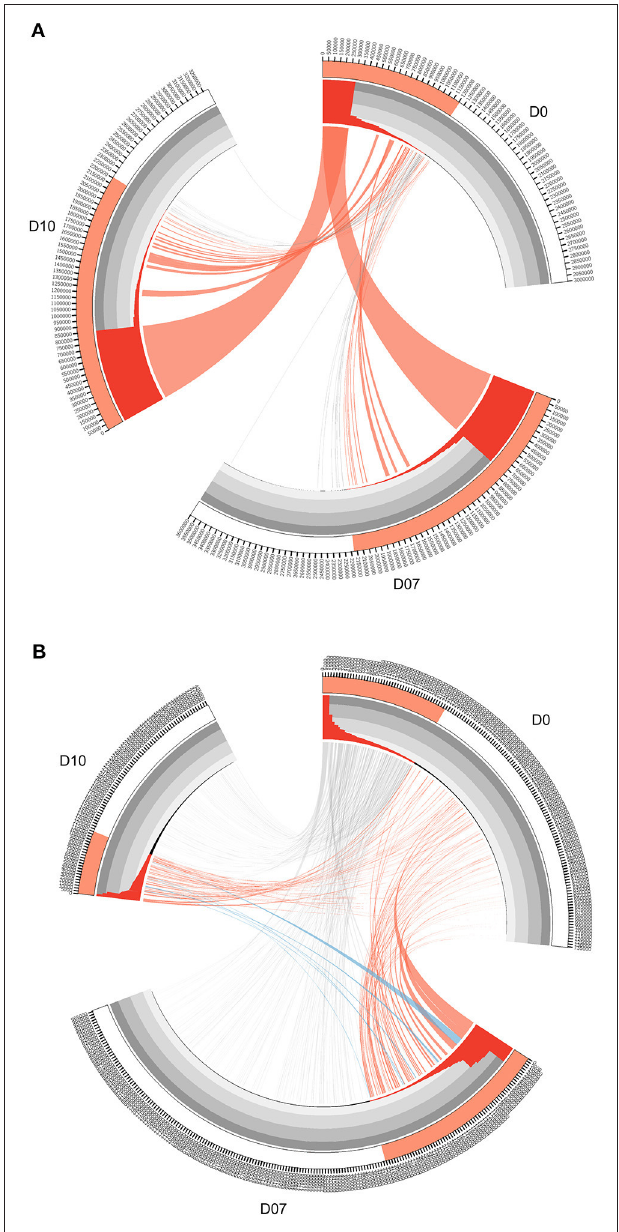
FIGURE 3 | Circos diagrams of pattern change of TRB clone frequency and IGH lineage frequency during the time course of final boost of rhesus macaques A5R069 from the N51 group. (A) Clones were sorted by their frequency at three different time points, the clone number of each time point is ticked on the outer lane. High abundance clones (>0.01%) are marked in red. The inner histogram lane shows the frequency of each clone with the height of each bar representing the relative abundance. The width of both the histogram and ribbon represents the frequency of each clone. Ribbons connect the same TCR clones at different time points. The ribbons connecting the high abundance clones at D7 and D10 that showed increase in frequency of more than 1-fold compared to D0 were labeled in red, those connecting the clones showing 50% decrease in frequency were labeled in gray, and those connecting the newly emerged clones that have high abundance (>0.01%) were labeled in blue (B) . IGH lineages were plotted similarly as in (A) , with the exception that red ribbons connecting high abundance lineages (>0.05%) at D7 and D10 that showed increase in frequency by more than 3-fold compared to